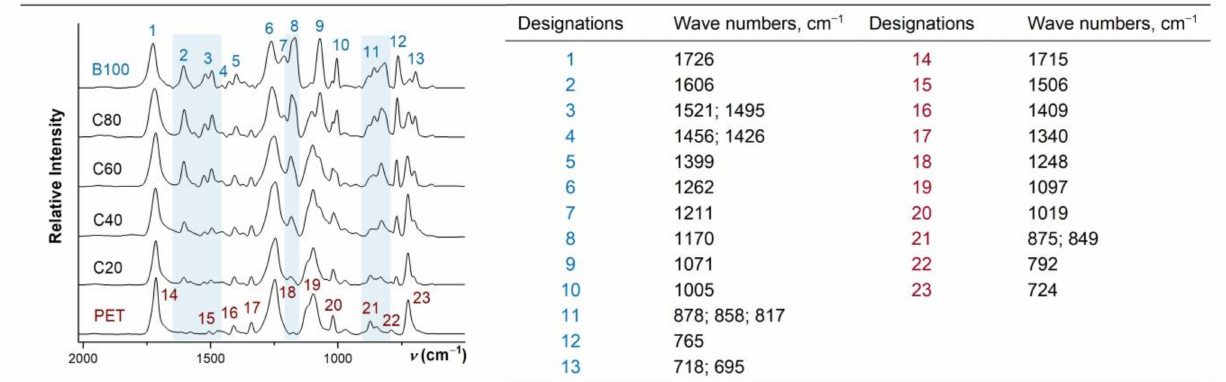
Figure 2. FTIR spectra of PET, homopolymer B100, and copolyesters C20–C80. The main signals decoded in the spectra of PET and B100 are also